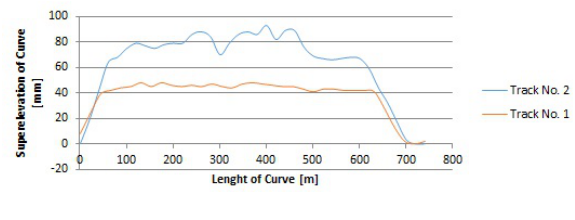
Figure 5. Cant in track No. 1 and in track No. 2 in curve